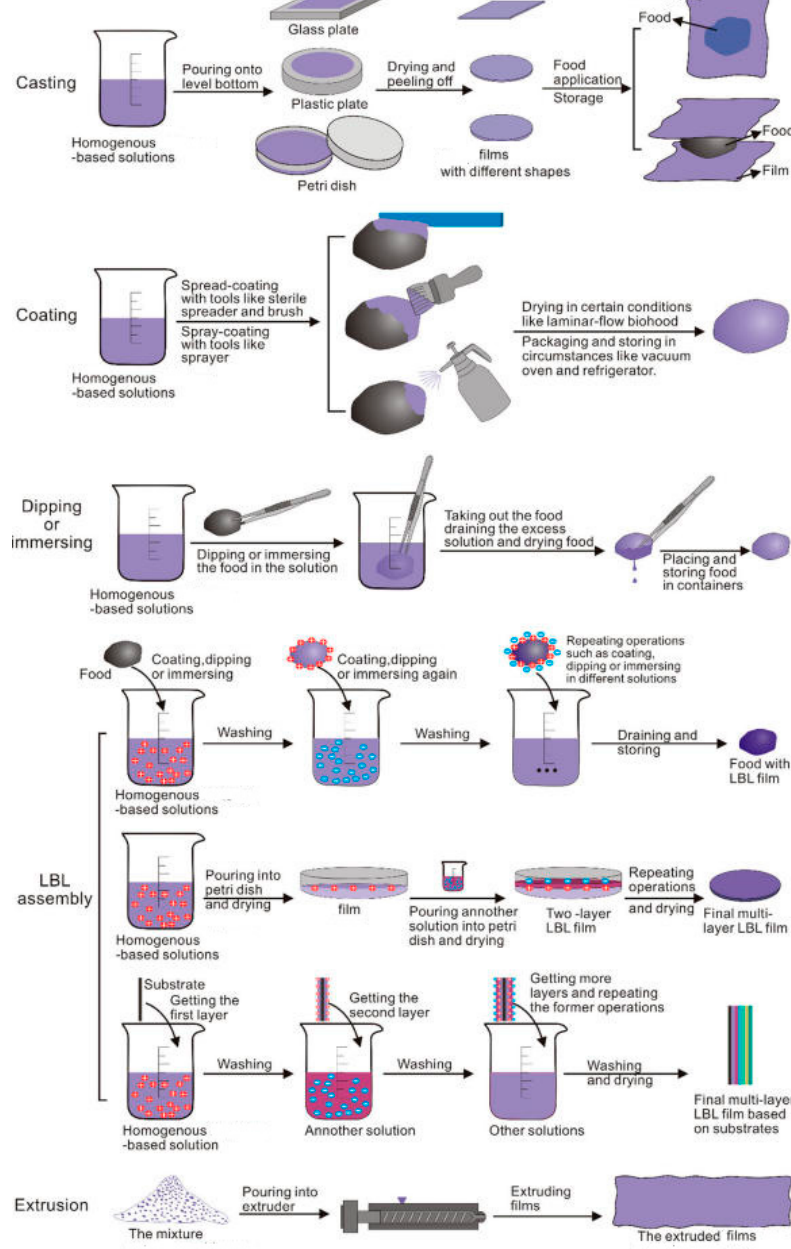
Figure 4. Ways of obtaining and applying films and coatings (adaptation by Wang, et al., 2018, [54]).